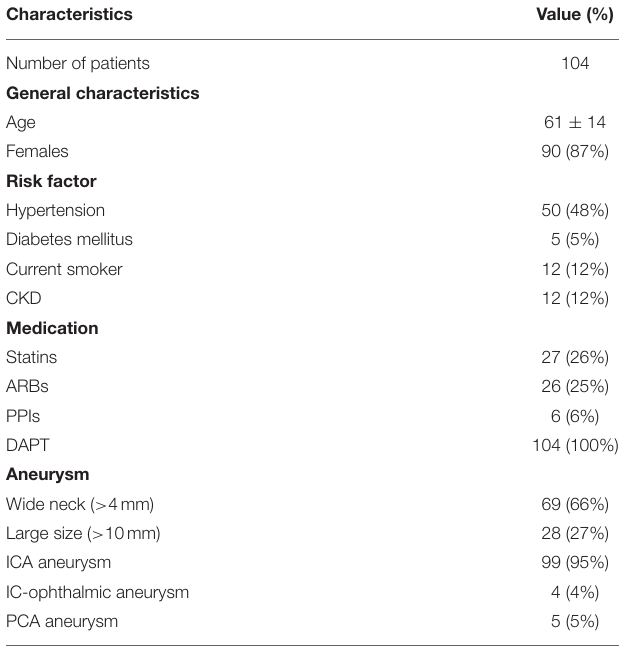
TABLE 1 | Clinical characteristics of the 104 patients.